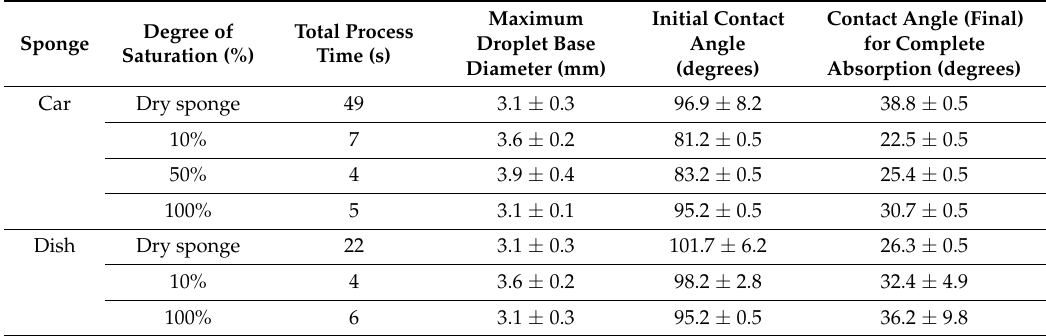
Table 2. The total time each droplet of concentrated surfactant solutions remained on the porous media with different degrees of saturation before being absorbed; the corresponding maximum base diameter and initial and final contact angle of the